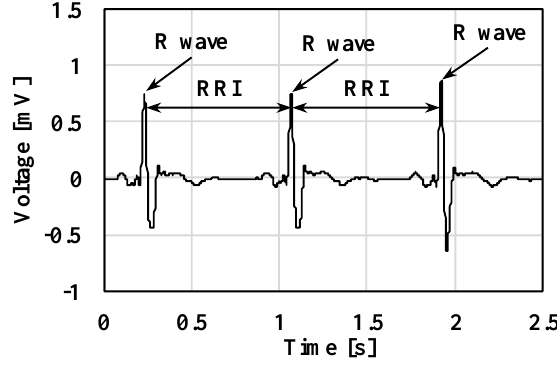
Figure 3. Electrocardiogram (ECG).